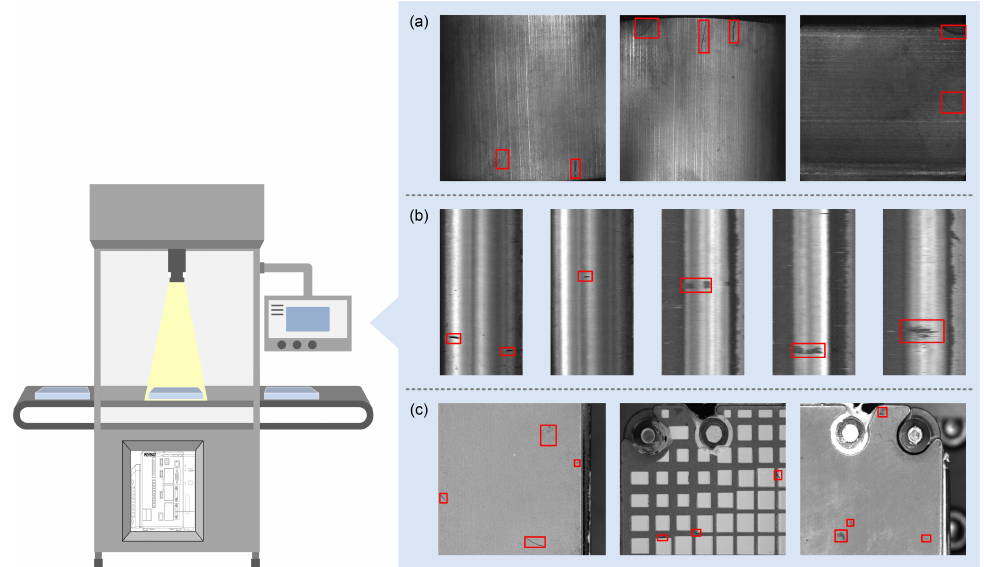
Figure 1. Objects in industrial vision inspection. ( a ) is the image data of the magnetic tile. ( b ) is the image data of the rail surface. ( c ) is the image data of the IGBT board surface. The characteristics of detection objects are very similar. It is necessary to carry out a more detailed detection of the